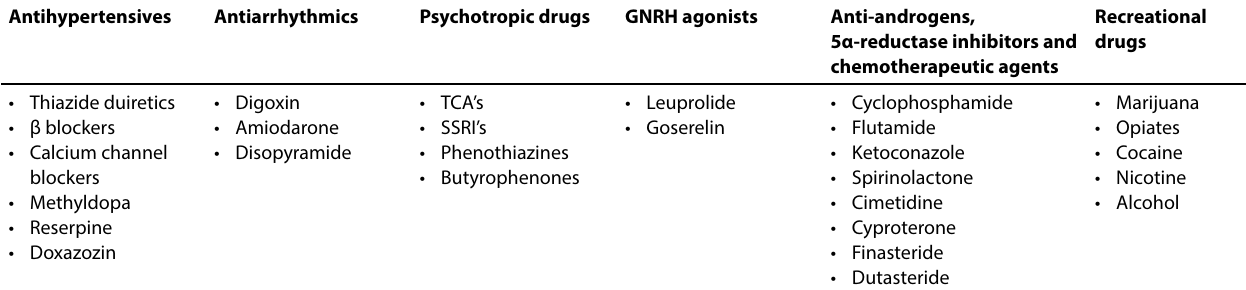
Table II. Drugs associated with erectile dysfunction